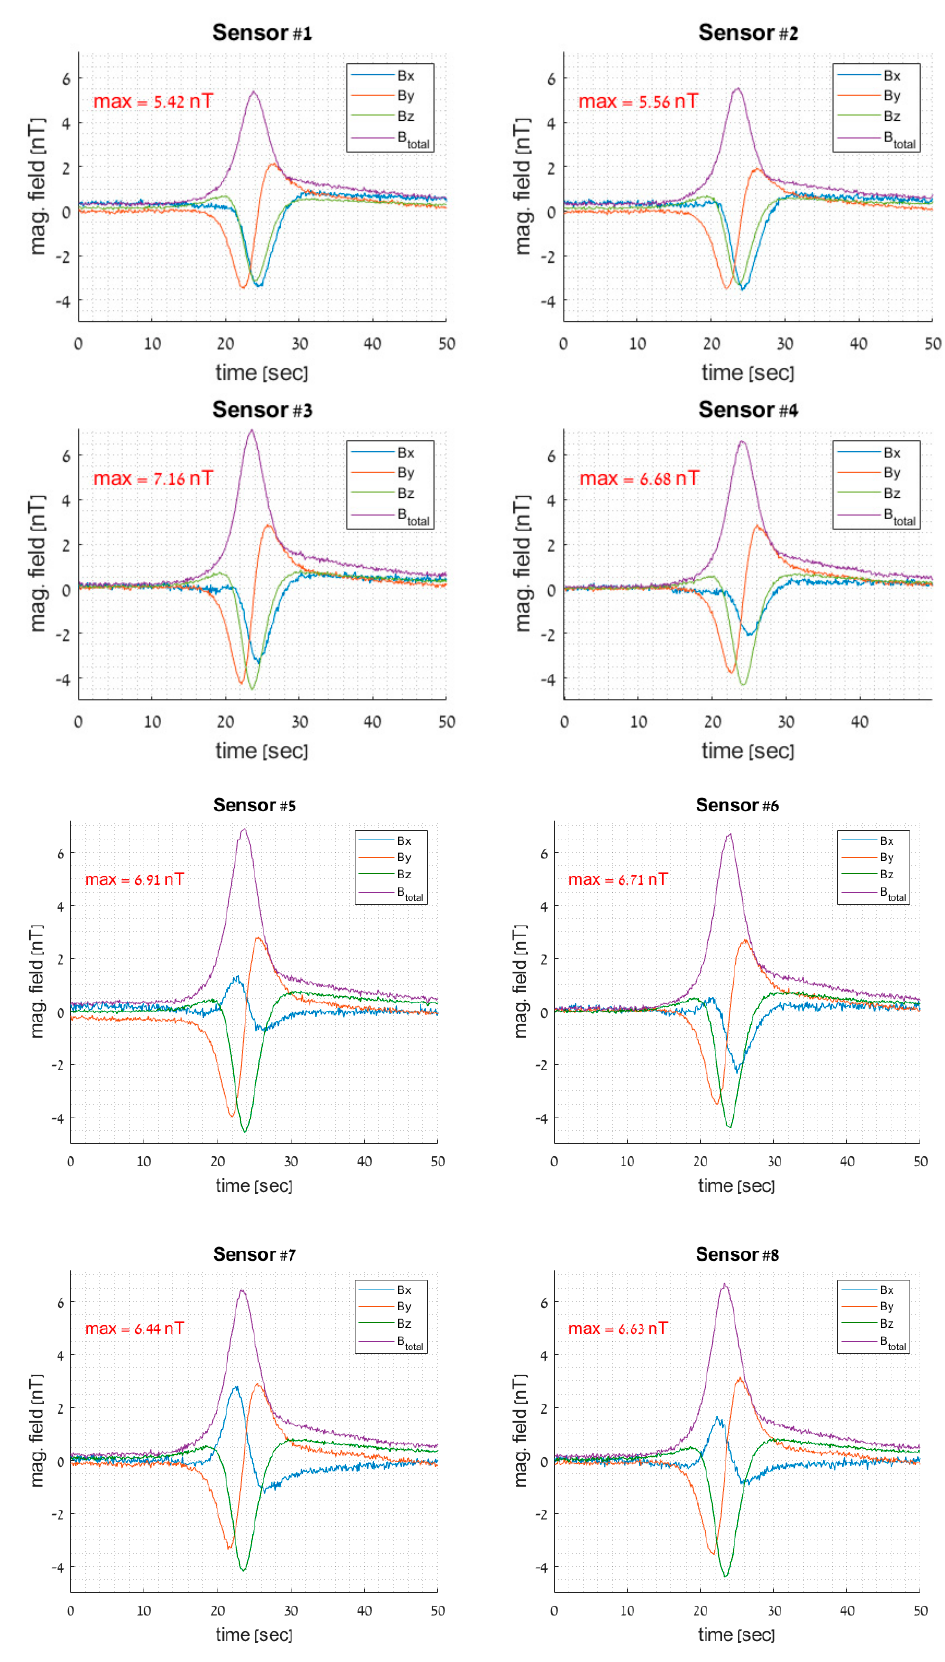
Figure 5. Typical raw data recorded during one of the events.